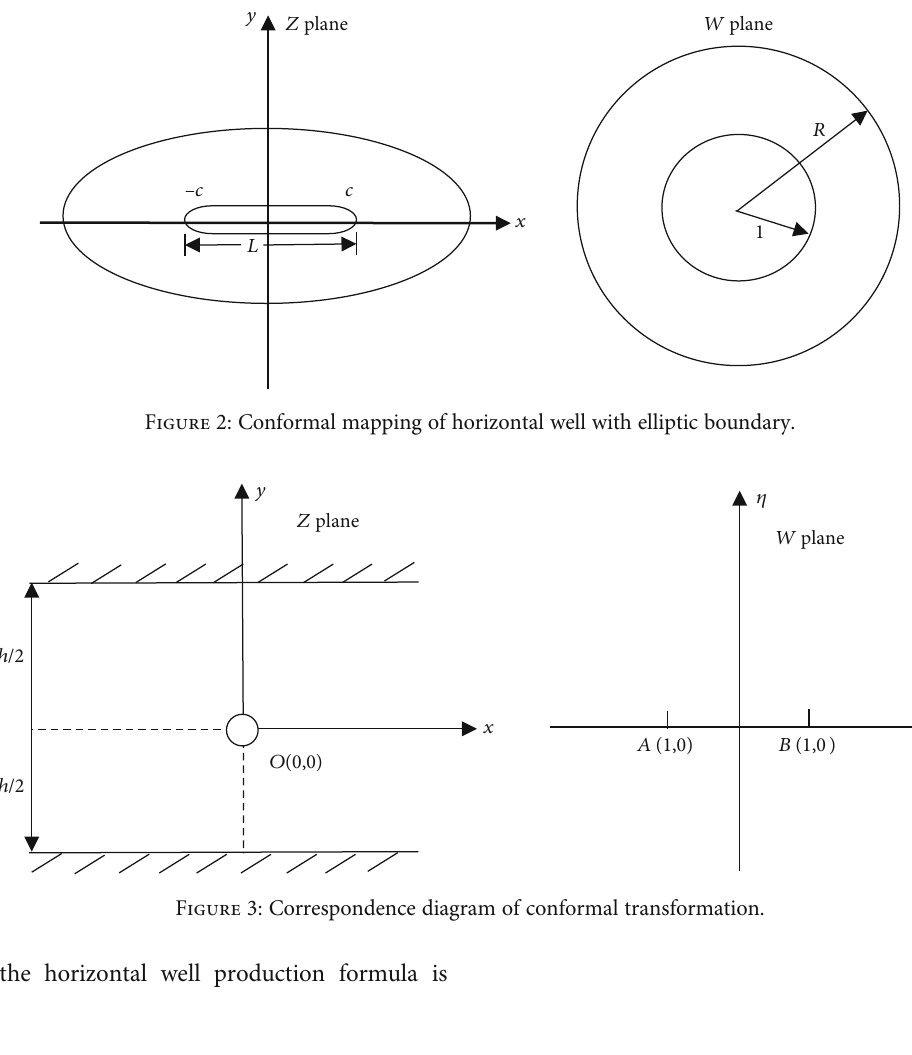
(cid:5) (cid:6)h in o(cid:1) (cid:3) p − r a ′ b ′ w